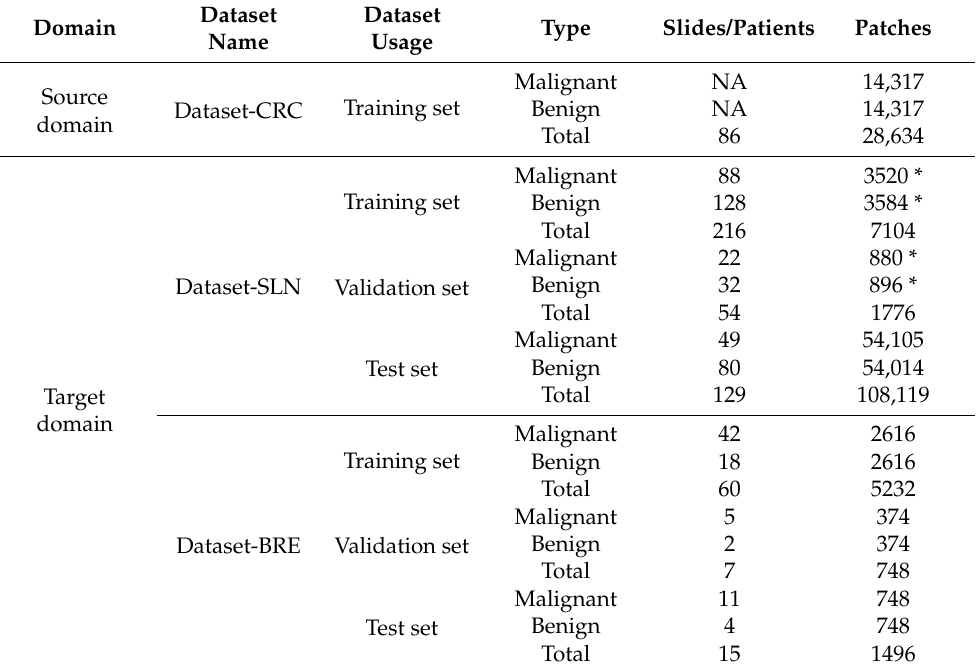
Table 2. The preprocessed